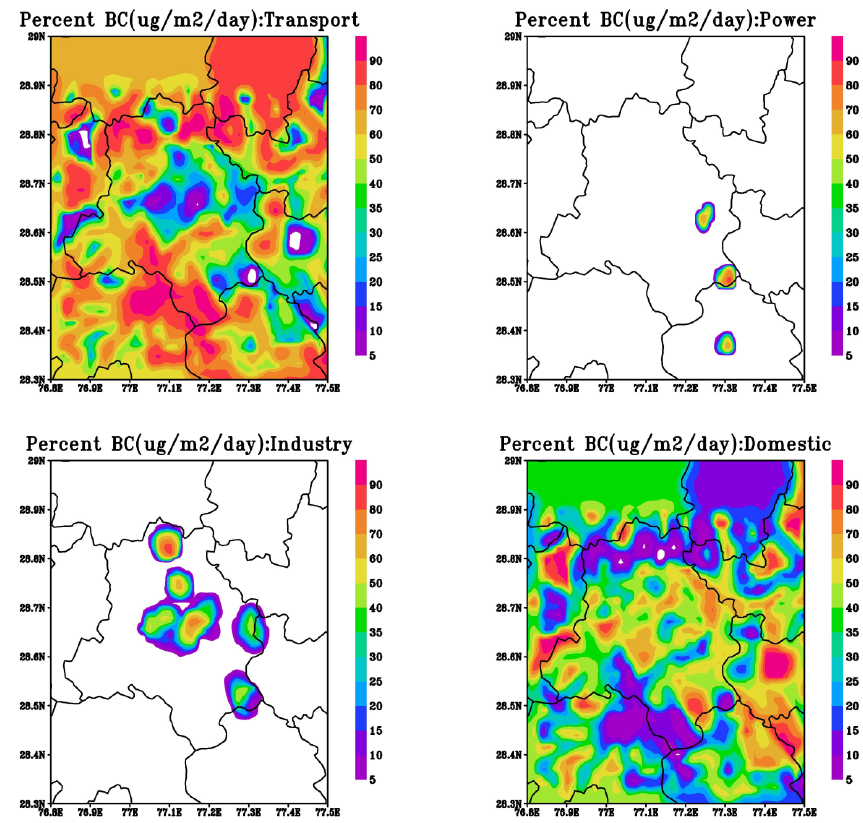
Figure 3. Sector contributions to Black Carbon emissions (%) for Delhi.